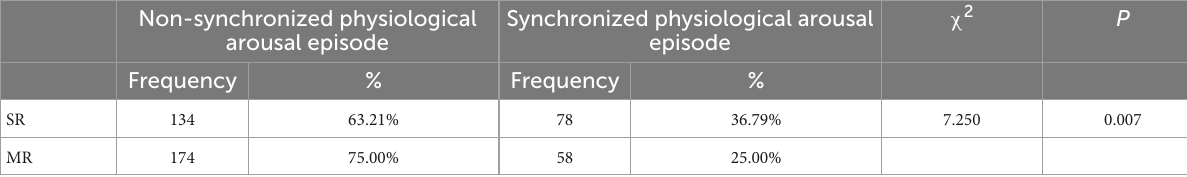
TABLE 7 Differences in synchronized physiological arousal episodes frequency under different social regulations. Non-synchronized physiological arousal